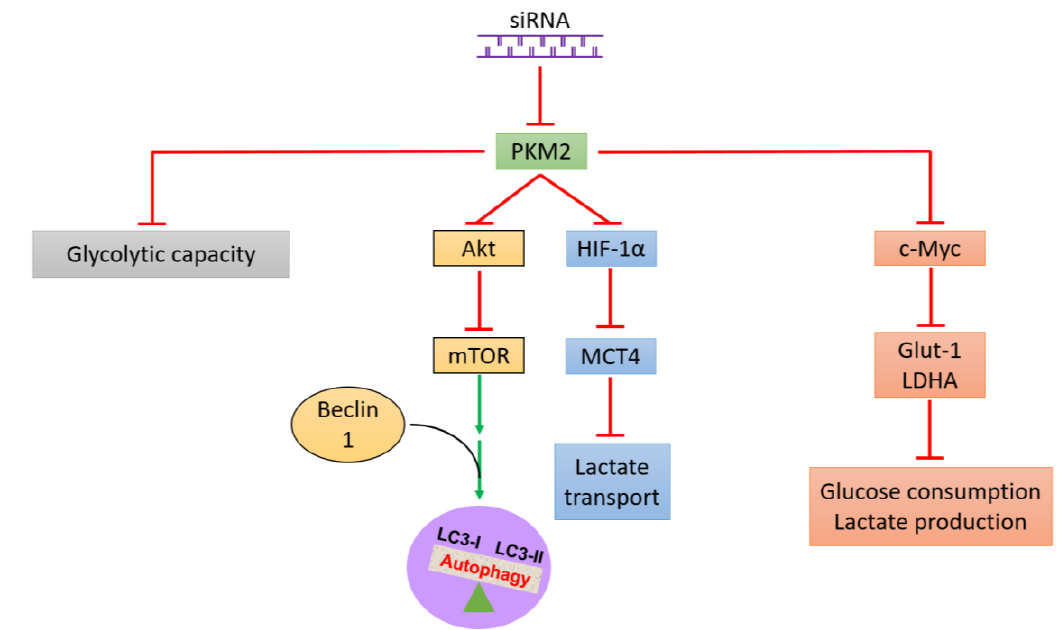
Figure 9. Schematic illustration of consequences of PKM2 expression knockdown to survival and related pathway expression in kidney cancer cells. PKM2 expression knockdown inhibits the AKT / mTOR signaling pathway, thereby activating autophagy and reducing the survival of human kidney cancer cells. Red T-bars represents the inhibition or suppression and green arrows indicates activation.